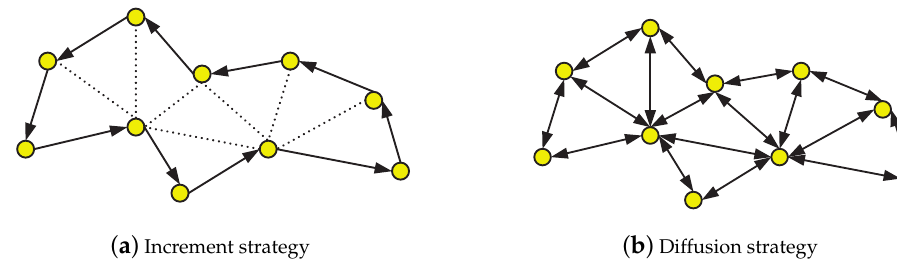
Figure 2. The IWSN with the distributed cooperative